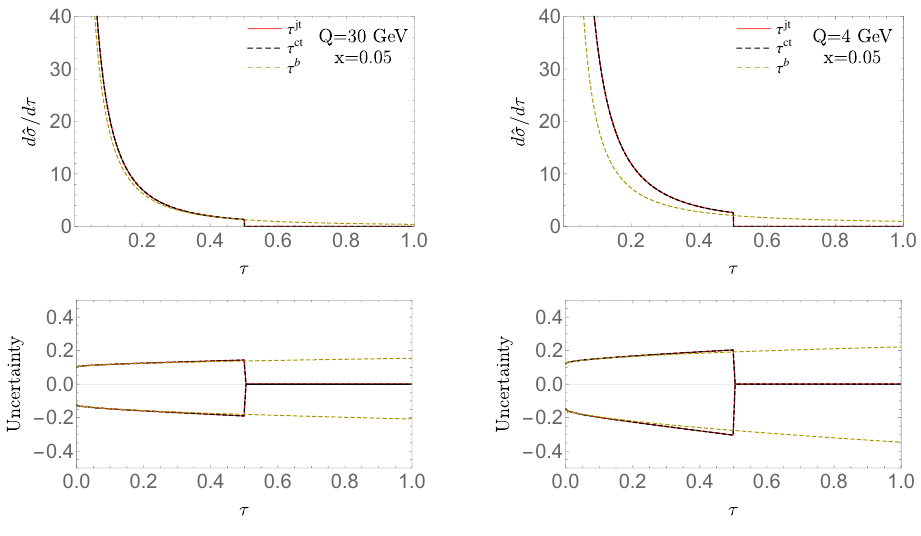
Figure 4 . Upper two figures are τ jt and τ ct distribution in comparison to τ b at Q = 30 GeV (left) and 4 GeV (right) with fixed values of x = 0 . 05 and R = 1 and lower ones are corresponding